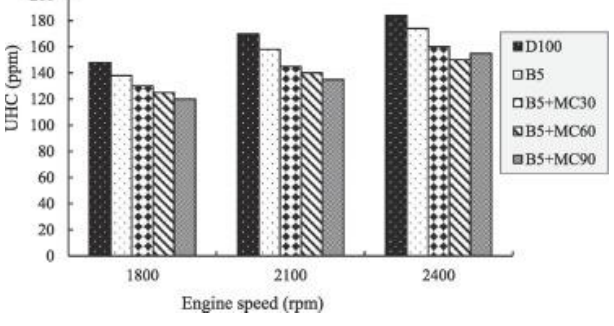
Fig. 7. Effect of the additive on UHC emission [14]